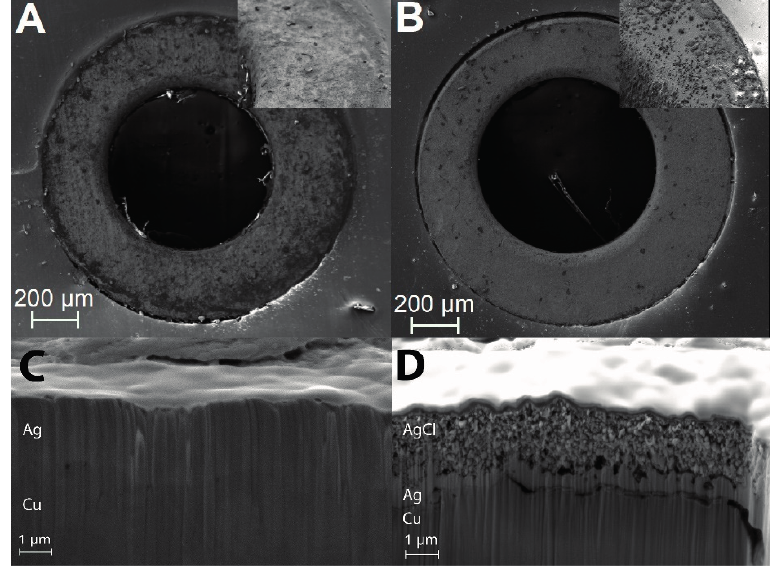
Figure 2. ( A ) Image of the PCB (Printed Circuit Board) pseudo-reference electrodes before (area on the right) and after (squared area on the left) NaOCl treatment; and ( B ) schematic cross-section of the Ag/AgCl reference electrode stack.